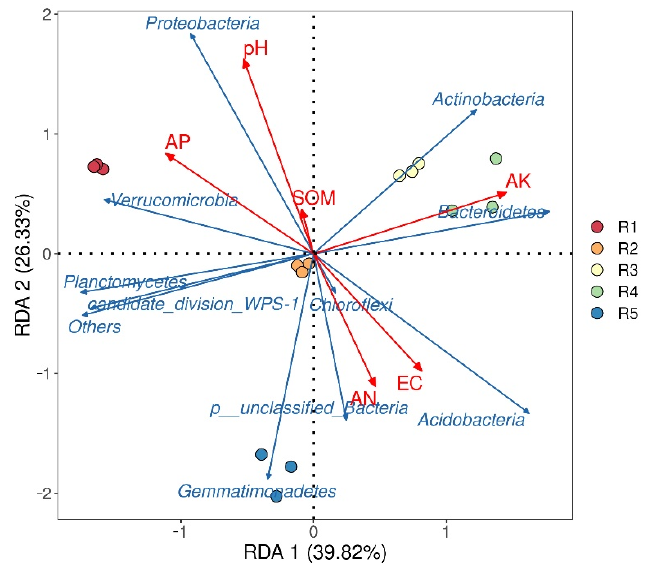
Figure 6. Redundancy analysis of the 10 dominant bacterial phyla and soil physicochemical properties. R1, R2, R3, R4, and R5 represent planting years for 1, 2, 3, 4, and 5 years, respectively. EC, electrical conductivity; SOM, soil organic matter; AN, available nitrogen; AP, available phosphorus; AK, available